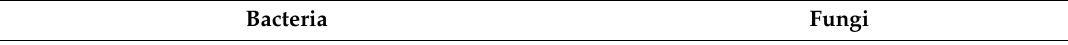
Table 5. Species present on the human feet skin surface marked out for sanitizing and antimicrobial properties of textile products.